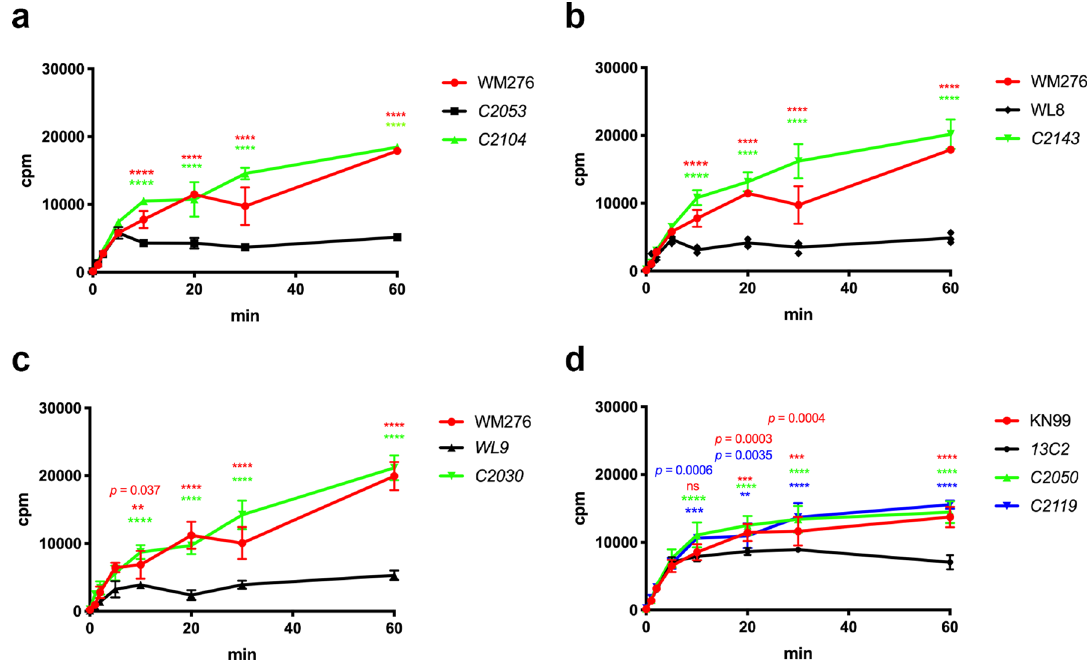
Fig. 7 The accumulation of [ 3 H] 5-FC is low in the uxs1 mutants and high in the suppressor strains. Cells were incubated with [ 3 H]- fl ucytosine and the accumulation of [ 3 H]- fl ucytosine was determined at indicated time. The experiments were repeated three times and data are presented as mean values ± standard deviation. Each panel contains the wild type, the uxs1 mutant and the suppressor strains derived from WM276 ( a ), WL8 ( b ), WL9 ( c ) and KN99 α ( d ). Two-way ANOVA with Tukey ’ s multiple comparisons test was used to compare the differences at the indicated time point between the uxs1 mutant and the wild type or between the uxs1 mutant and the suppressor strain (ns = not signi fi cant, ** p < 0.0021, *** p < 0.0002, and **** p <